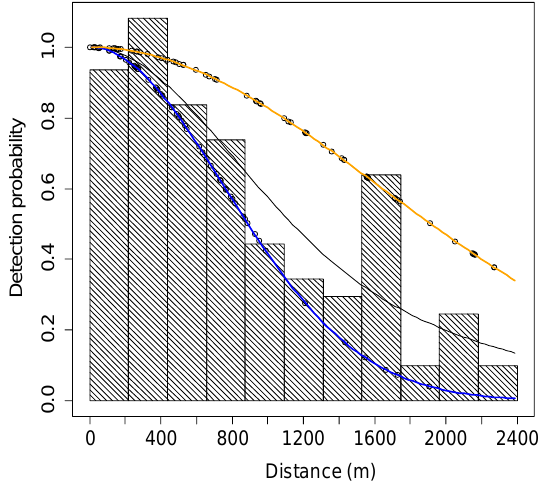
Figure 7. Bowhead whale detection function for non-fjord strata. Circles are the probability of detection for each sighting given its perpendicular distance and covariate value “cloud cover”. Lines are the fitted model for the average (black), low level of the covariate (blue) and high level of the covariate (orange, cloud cover > 50%).